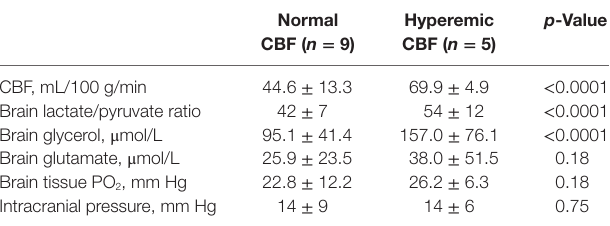
TaBle 3 | Episodes of cerebral energy dysfunction categorized according to cerebral blood flow (CBF), dichotomized as normal vs. hyperemic.